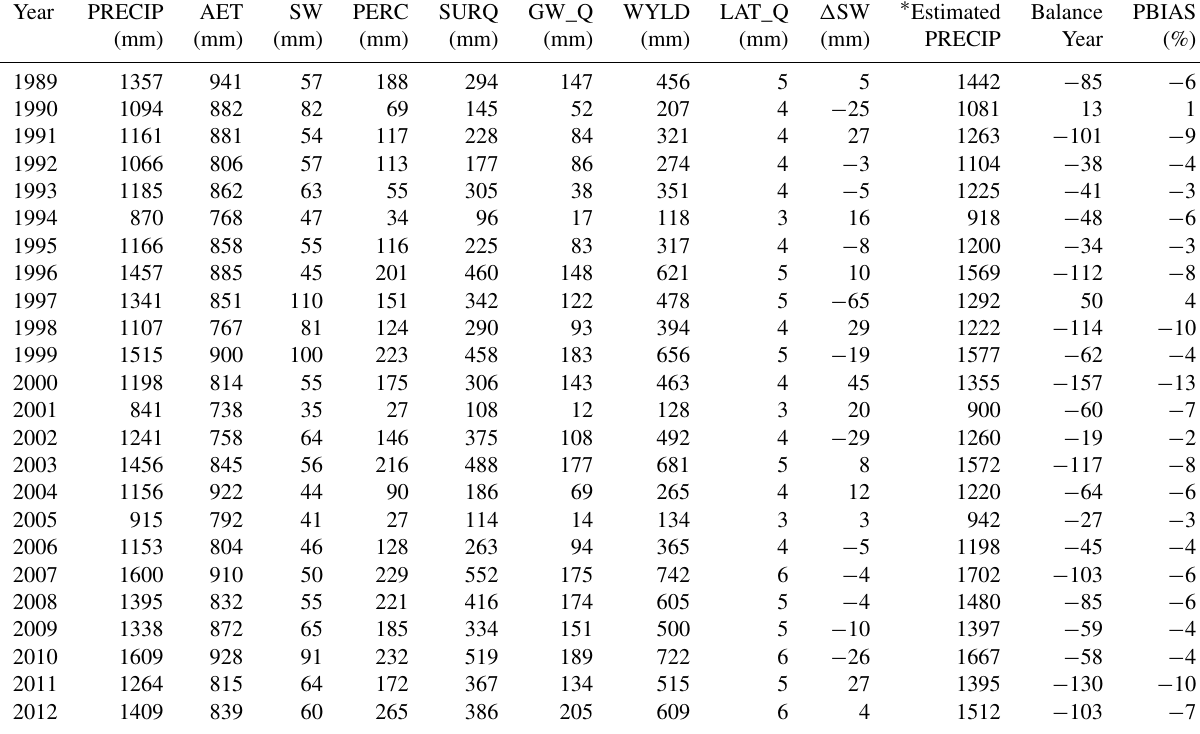
Table 3. Average annual water balance at the outlet of the watershed in Abeokuta based on SWAT-simulated output.